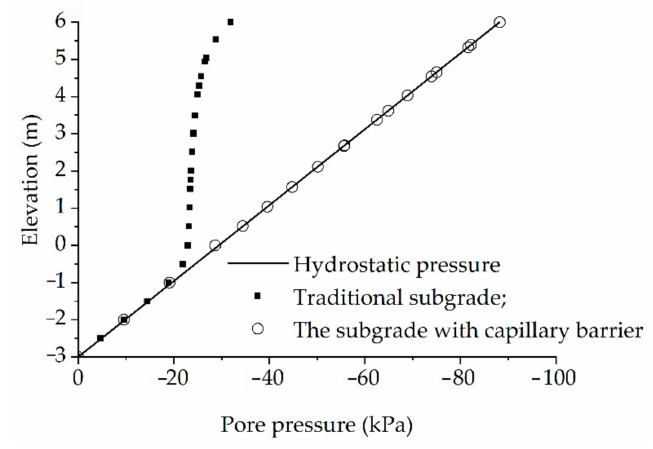
Figure 6. Pore-water pressure profiles at section I-I.